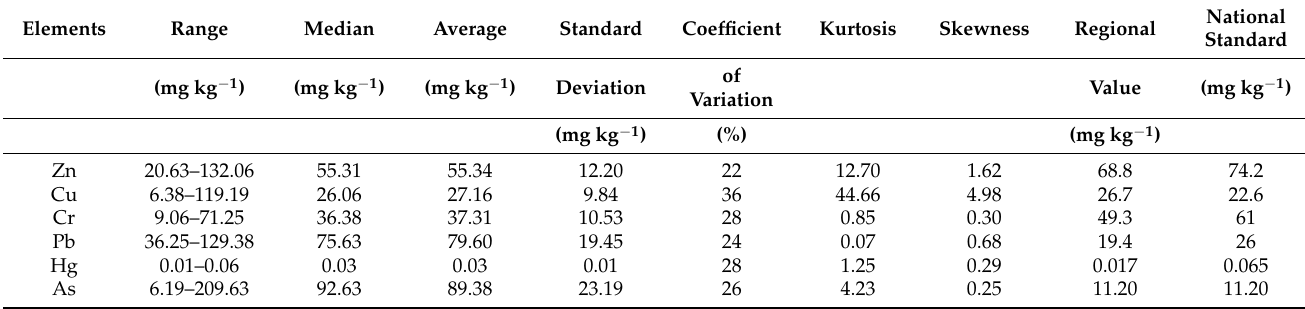
Table 3. Descriptive statistics of the heavy metals in